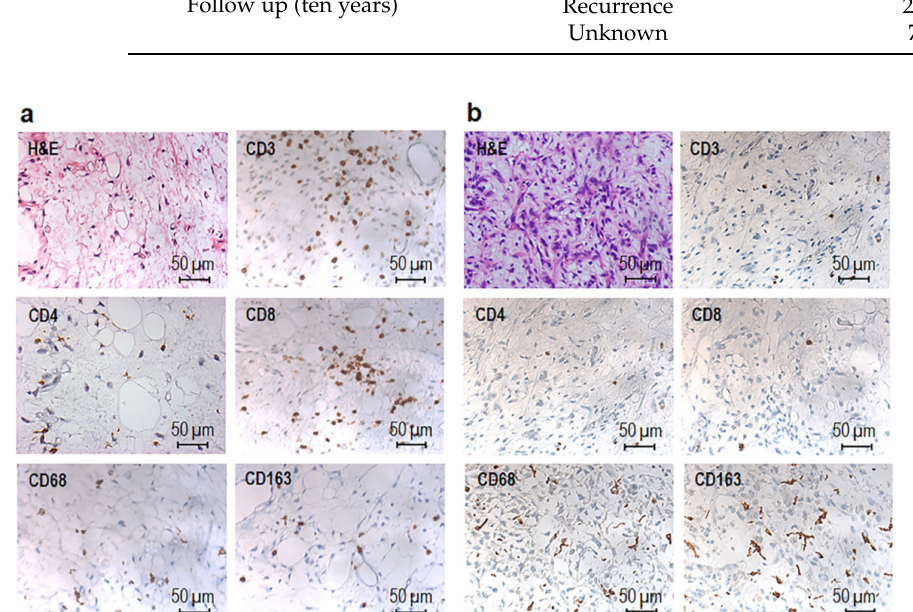
Figure 1. Immunohistochemical characterization of immune infiltrate in MLPS tissues. Representative images of H&E and IHC staining of CD3+, CD4+, CD8+, CD68+, and CD163+ positive cells in FFPE sections from a low grade MLPS ( a ) from patient #21 and high grade. MLPS tissues ( b ) from patient #4, acquired at 200 ×